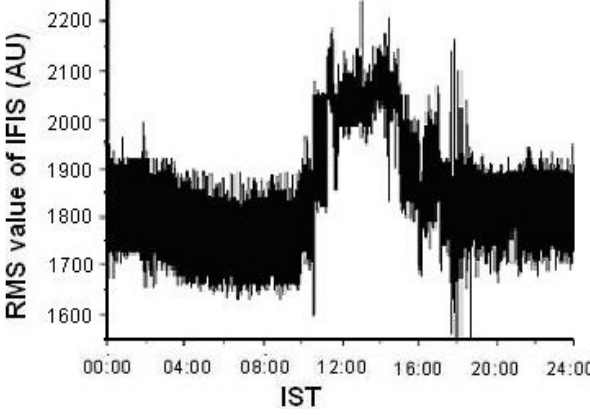
Fig. 8. A typical record of sferics at 6kHz during a thunderstorm over North Tripura at a distance